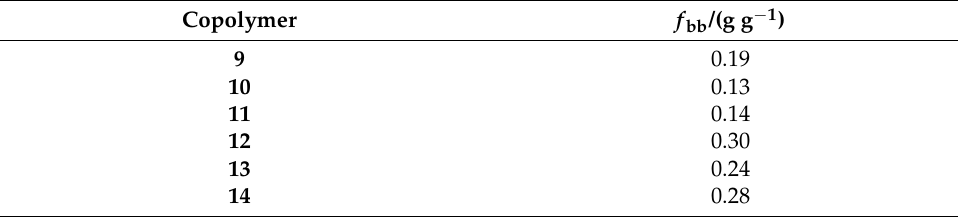
Table 3. Structural characteristics obtained using SEC: Mass fraction of the cellulosic backbones f bb .